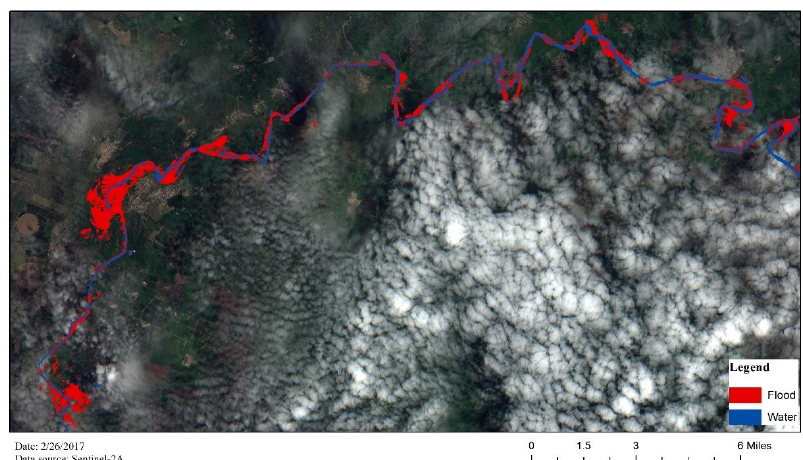
Figure 7 . Flood inundated areas in study area on February 27, 2017 extracted by decision-level data fusion method.